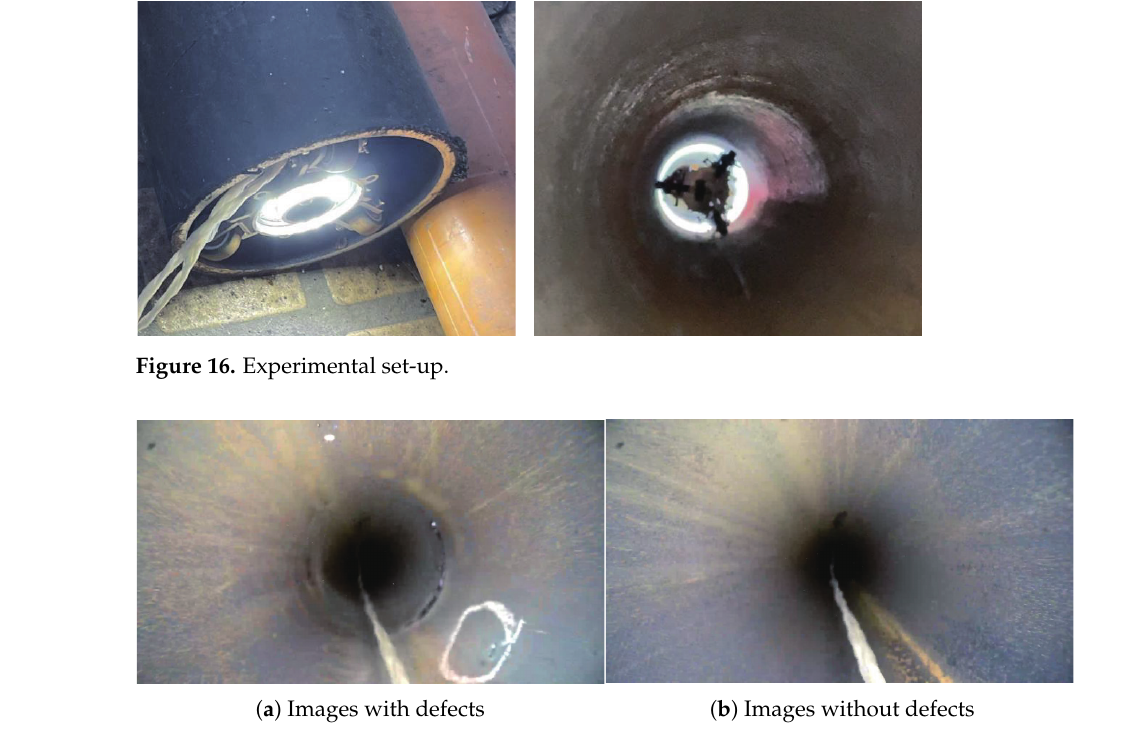
Figure 17. Images of the inner wall surface of the pipe.